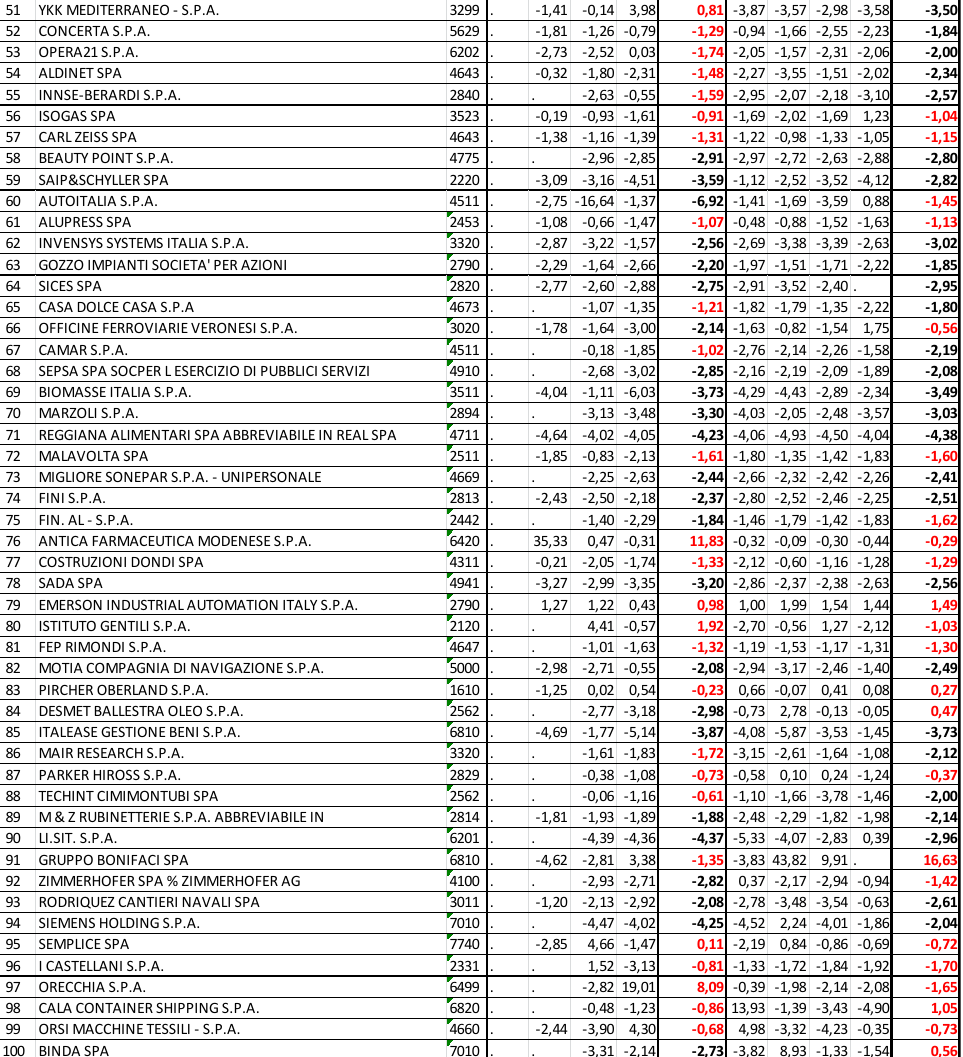
Code values represent the industry in which each company operates according to the UK Standard industrial classification of economic activities (SIC) as updated in 2007;  Values represents the Beneish score for each year while the average value is introduced separately for the pre-crises period (2005-2008) and for the crises period (2009-2012);  Score values expressed in red font represent those higher than the Beneish threshold for high probability of EM